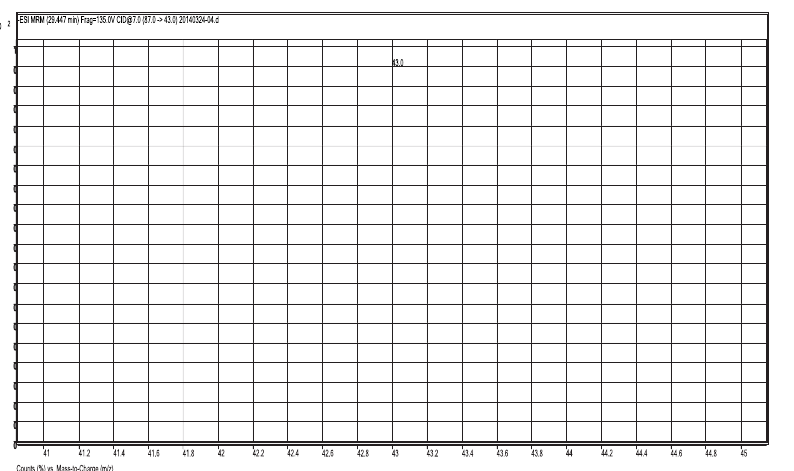
Fig. 9. Chromatogram of pyruvic acid with triple quadrupole LC